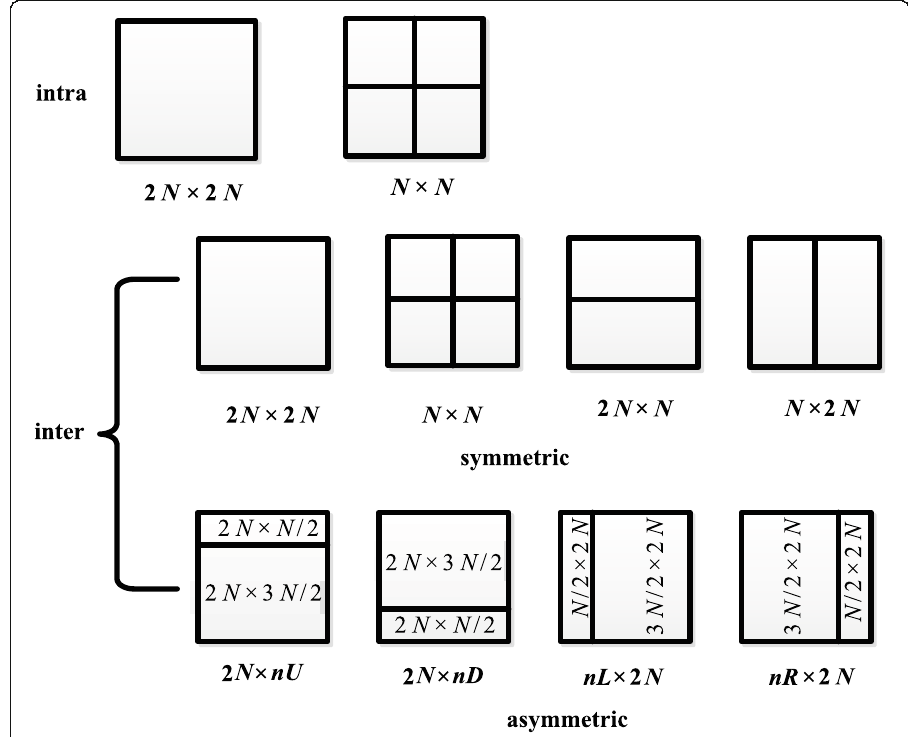
Fig. 2 PU partition modes in different prediction